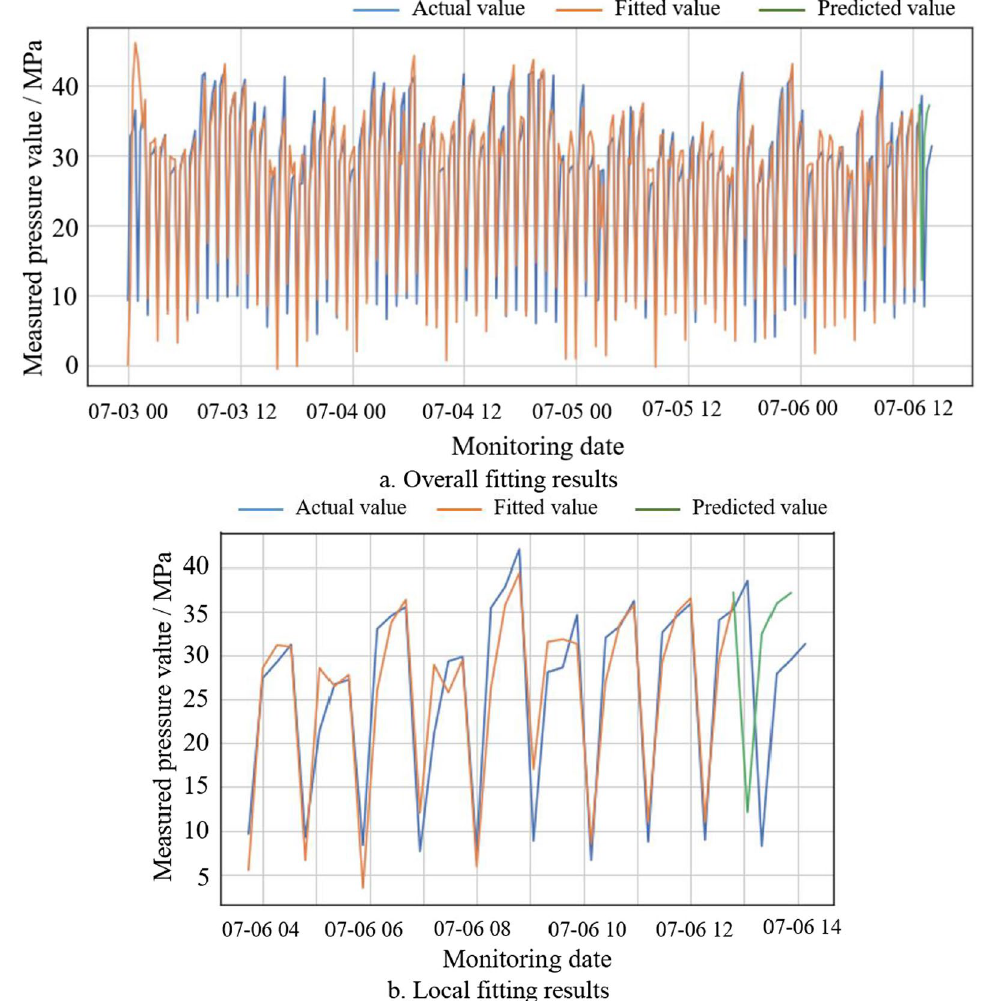
Fig. 11 ARIMA model fitting